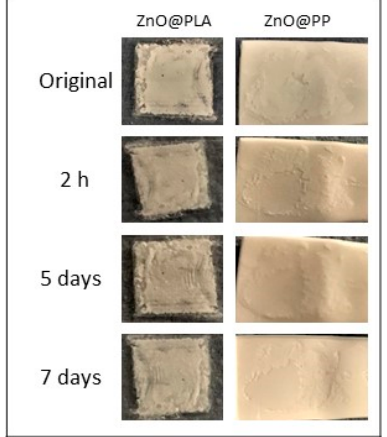
Figure 9. ZnO@PLA and ZnO@PP samples after different time intervals in SBF solution.